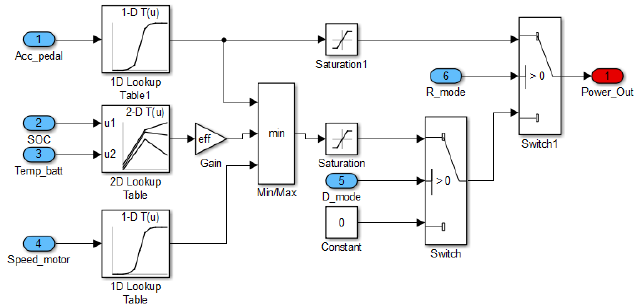
Figure 1. Schematic diagram of the actual output power control method.